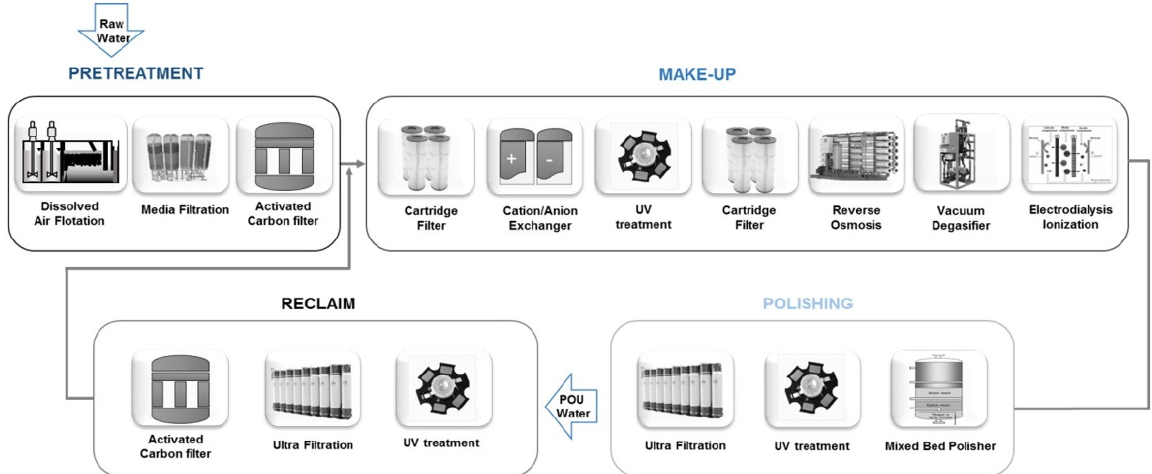
Figure 6. Schematic flow of a complex UPW production system for microelectronics manufacturing. A typical hybrid membrane treatment plant is presented which involves a combination of RO-MBDI-UF to provide microelectronics grade UPW. Reprinted from [145], with permission from Elsevier.